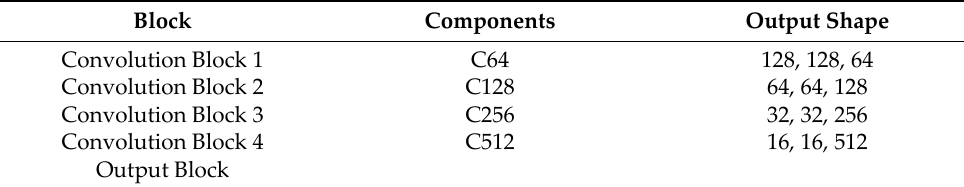
Table A2. Architecture of the discriminator